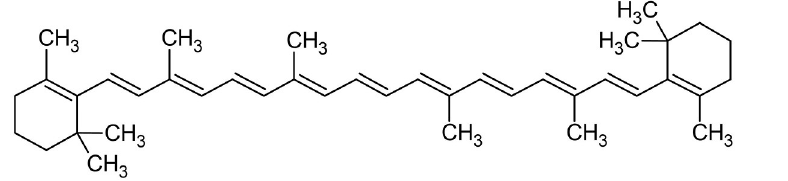
Fig 2. Chemical structure of β -carotene.